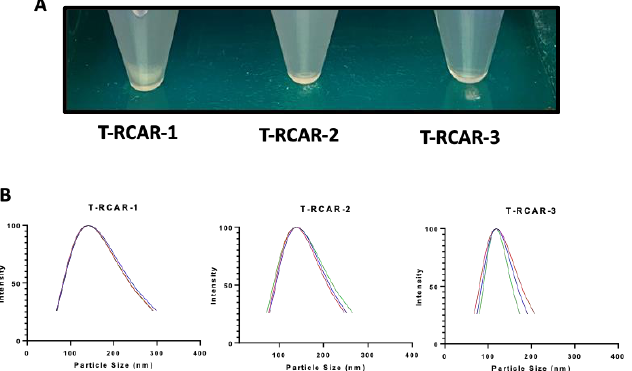
Figure 3. Transfersome visualization and size distribution after one year of storage in the refrigerator. ( A ) Photo of formulations after storage at 4 ◦ C for one year. ( B ) Transfersome size distribution for the T-RCAR-1, -2, and -3 after storage for one year at 4 °C. The data plotted for each formulation are the triplicated reading for one sample (n = 1). Lines in different color: the particle size analysis was run three times for each formulation.